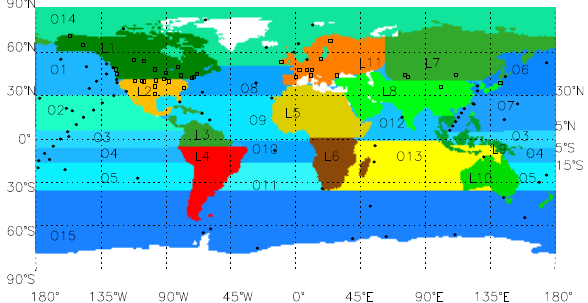
Fig. 4. The locations of the observing stations (72 stations on the ocean (closed circle), 36 stations on the land (open square)), and the regions over the globe (15 ocean regions and 11 land regions). The stations in one region were grouped. The ocean was divided into 15 regions, and the stations on the ocean were grouped into 15 groups. The land was divided into 11 regions, and the stations on the land were grouped into 11 groups. L1: North American boreal, L2: North American Temperate,L3:South